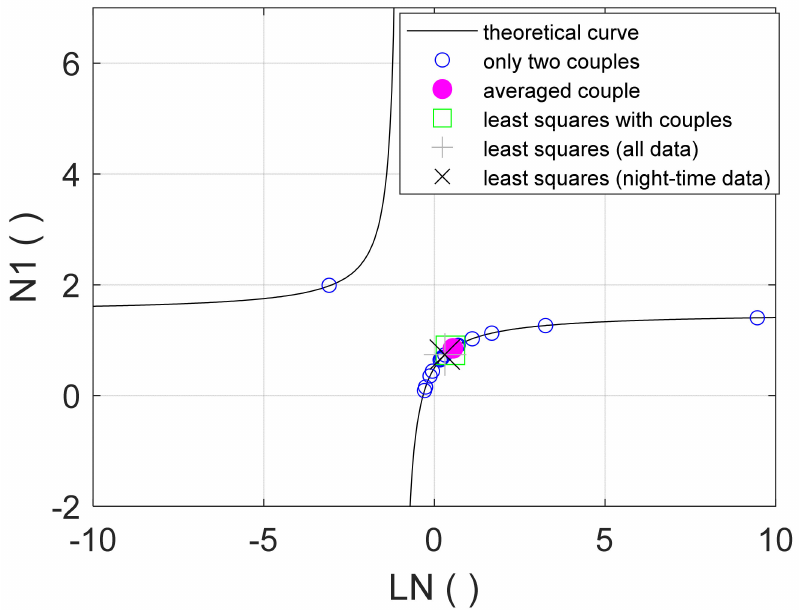
Figure 9. Theoretical equation for converting between the FAVAD and power equations (black line) compared with the values of N 1 and LN obtained with data with a 60 min time step using MET1 in blue, MET2 in magenta, MET3 in green, MET4 in gray, and MET5 in